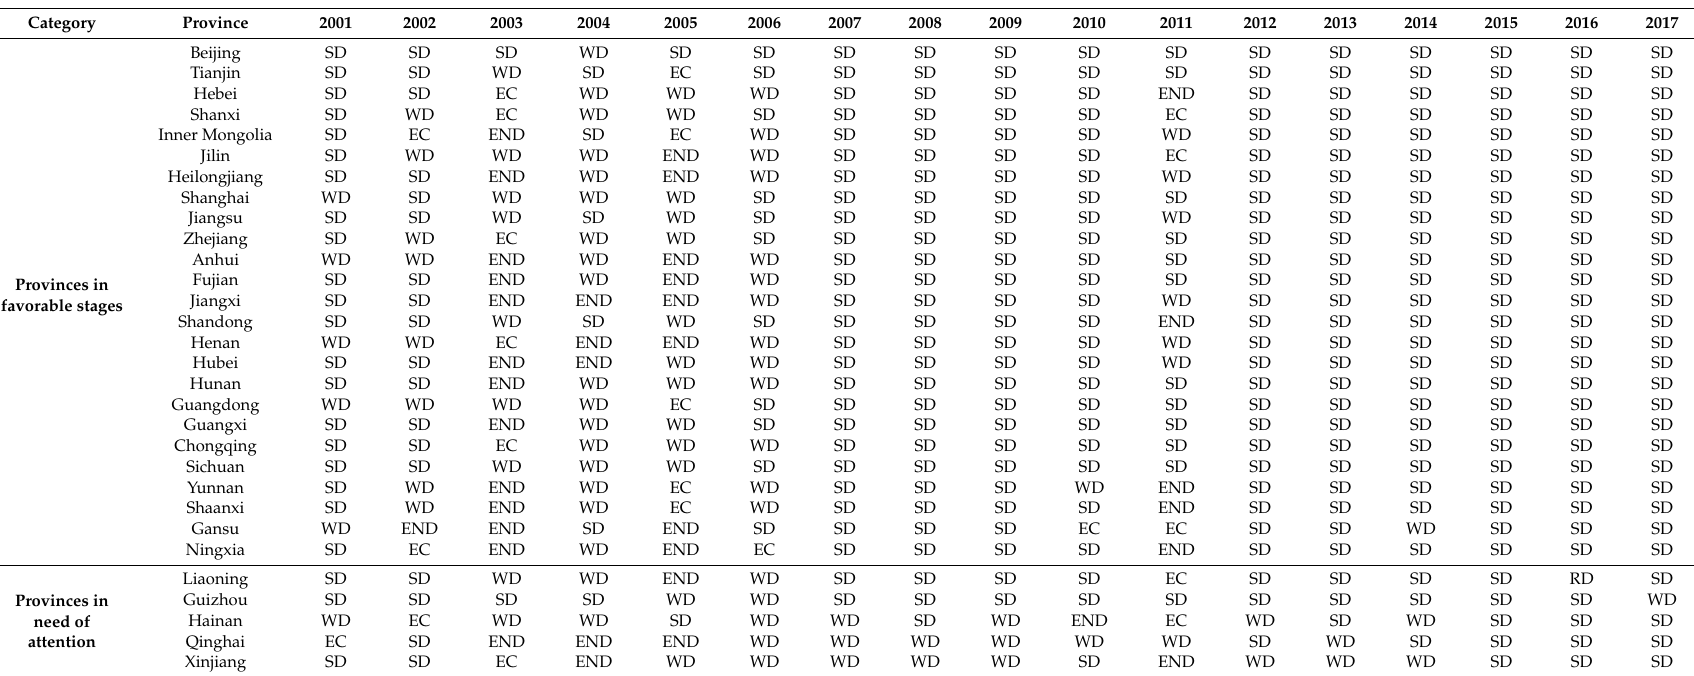
Table 4. Annual decoupling condition of each